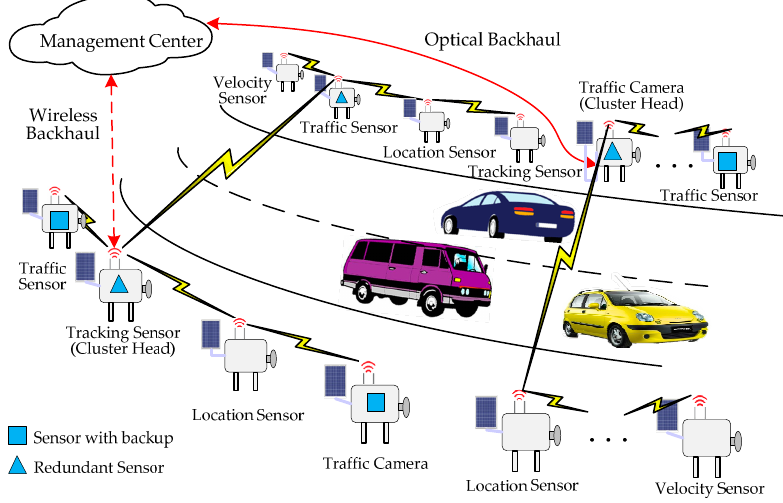
Figure 1. An illustration of an ORSN scenario.